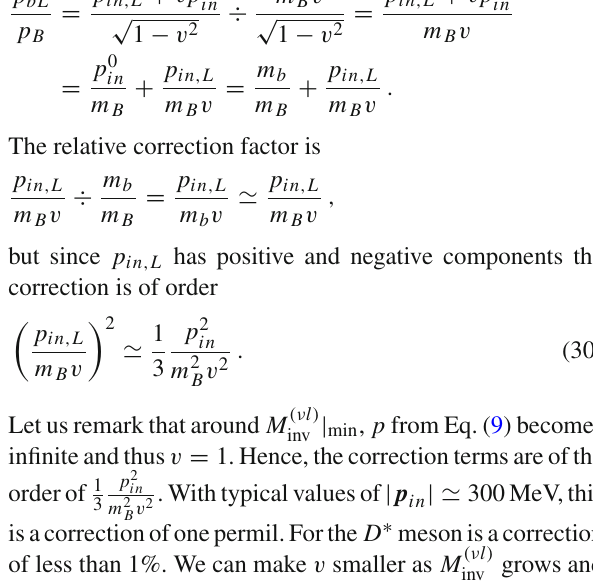
| − d Γ | M (cid:7) =− 1 M (cid:7) =+ 1 of Eq. (29) as dM (ν l ) inv dM (ν l ) inv